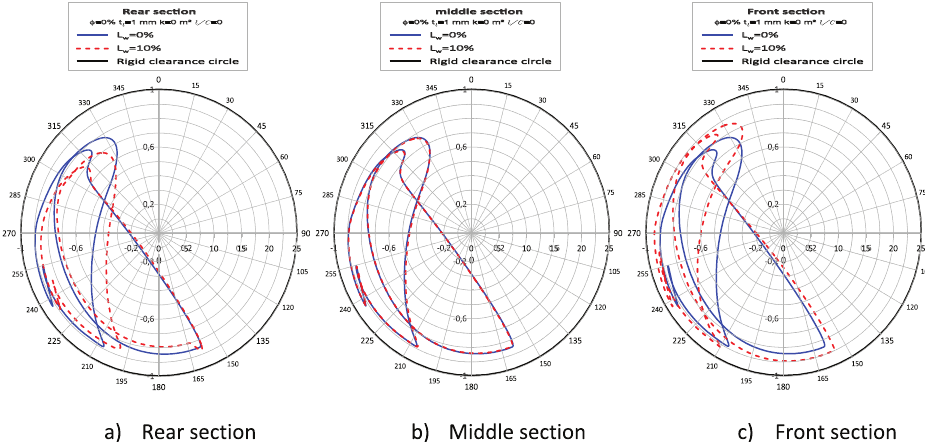
Fig. 7. Effects of the dynamic misalignment parameter L W on the stationary crankshaft center orbits for the Newtonian case.